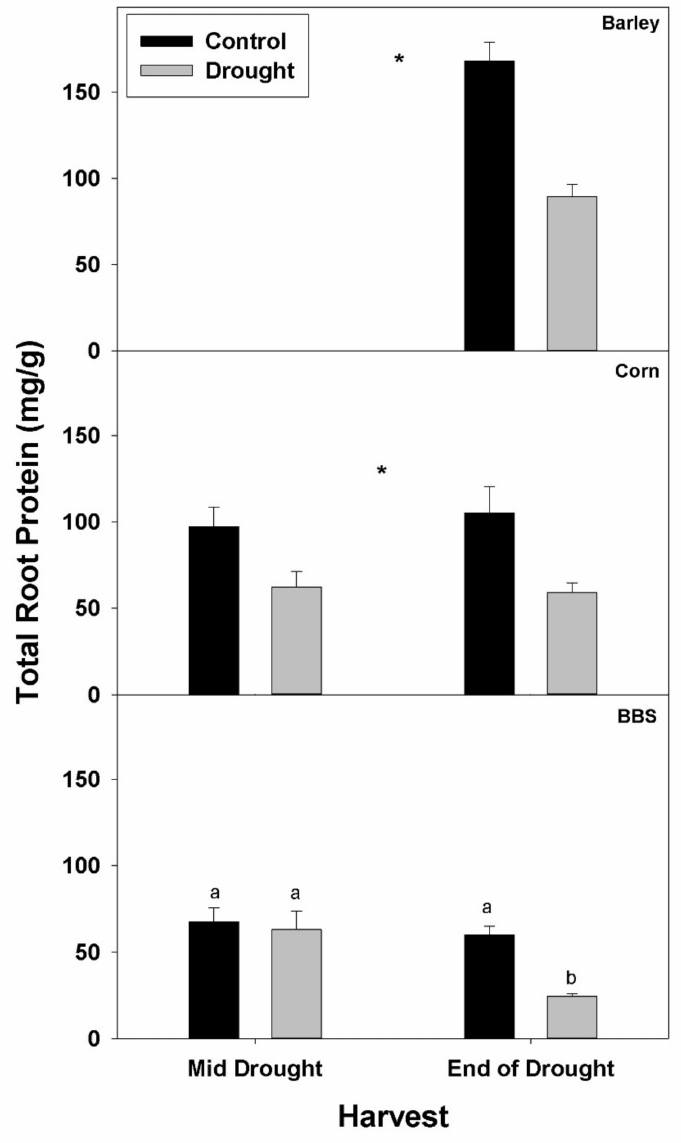
Figure 4. Effects of control vs. drought treatments on the concentration of total protein per dry mass of roots in barley, corn, and big bluestem (BBS). Each bar represents mean + 1 SE (standard error). Within each panel, bars not sharing the same letters are significantly different. For each response variable, significant effects of drought (ANOVA), across both harvest in corn and big bluestem, are indicated with an asterisk